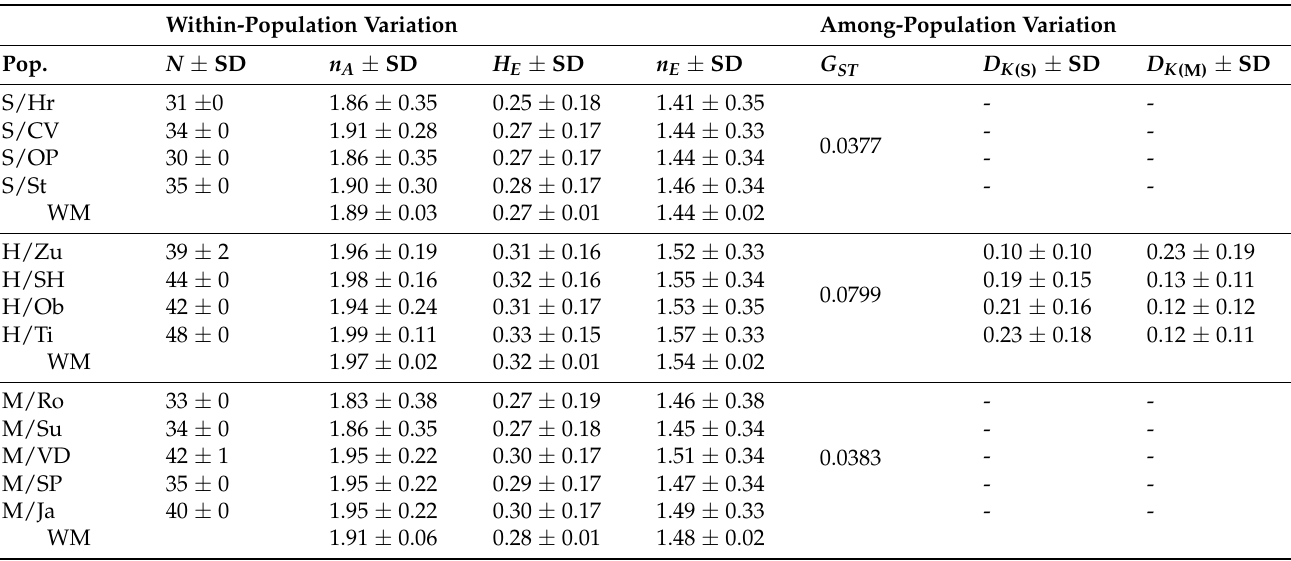
Table 3. Population genetic summary statistics for P. sylvestris , P. mugo , and their putative hybrid swarms in Slovakia (pop. abbreviations in Table